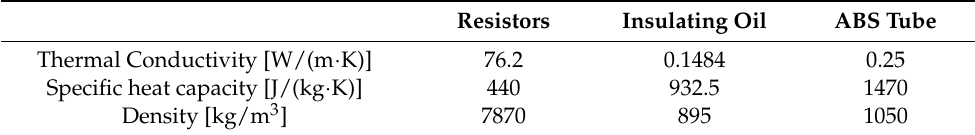
Table 1. Material